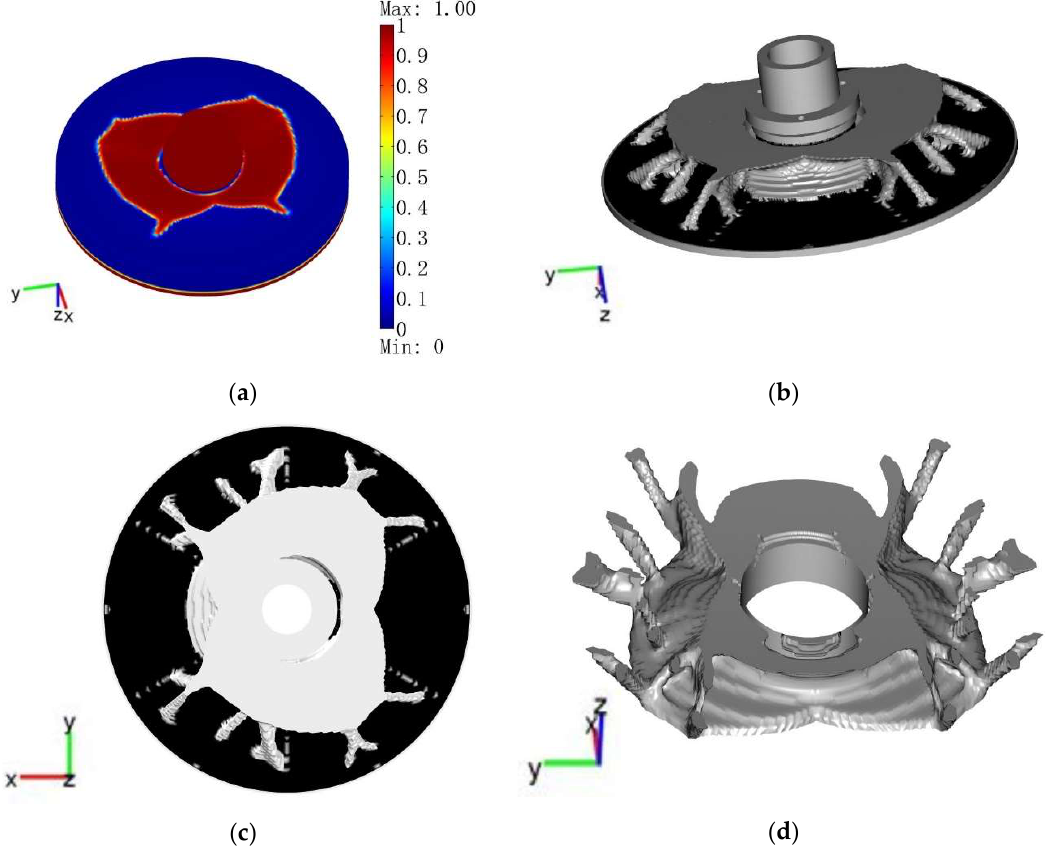
Figure 12. Optimization results in the horizontal condition of the optical axis. ( a ) The density of the mirror; ( b ) Mirror structure with a density threshold of 0.6; ( c ) Bottom view of the optimized mirror; ( d ) Optimal structure of the design